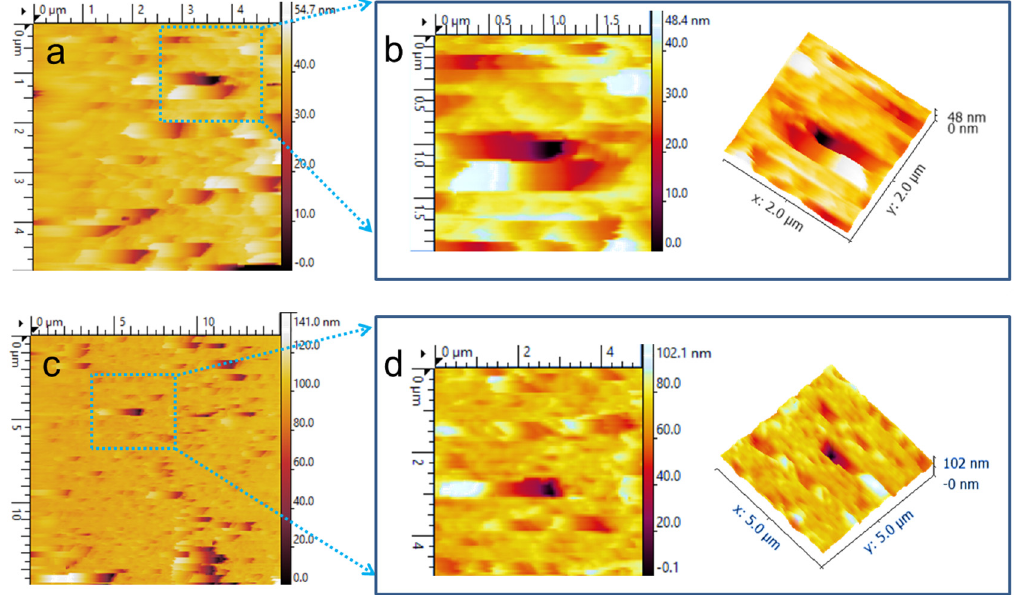
Figure 7. AFM imaging of pores fabricated in thin silicon membrane. ( a , b ) Sample A with pore size 180 ± 12 nm fabricated under J = 0.47 mA/cm 2 with 5% HF and ( c , d ) Sample B with pore size 520 ± 22 nm fabricated under J = 1.57 mA/cm 2 with 10% HF. ( a ) 5 × 5 μ m 2 ; ( b ) 2 × 2 μ m 2 ; ( c ) 15 × 15 μ m 2 ; and ( d ) 5 × 5 μ m 2 .